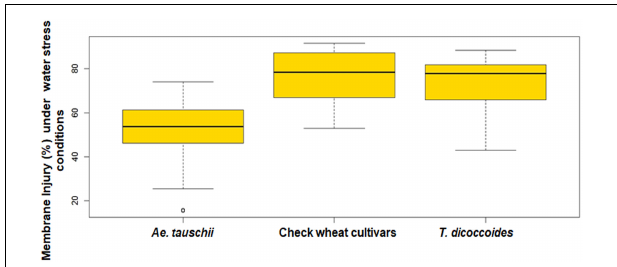
FIGURE 7 | Boxplots representation of per cent membrane injury in accessions of Ae. tauschii , T. dicoccoides and check wheat cultivars under water stress conditions.